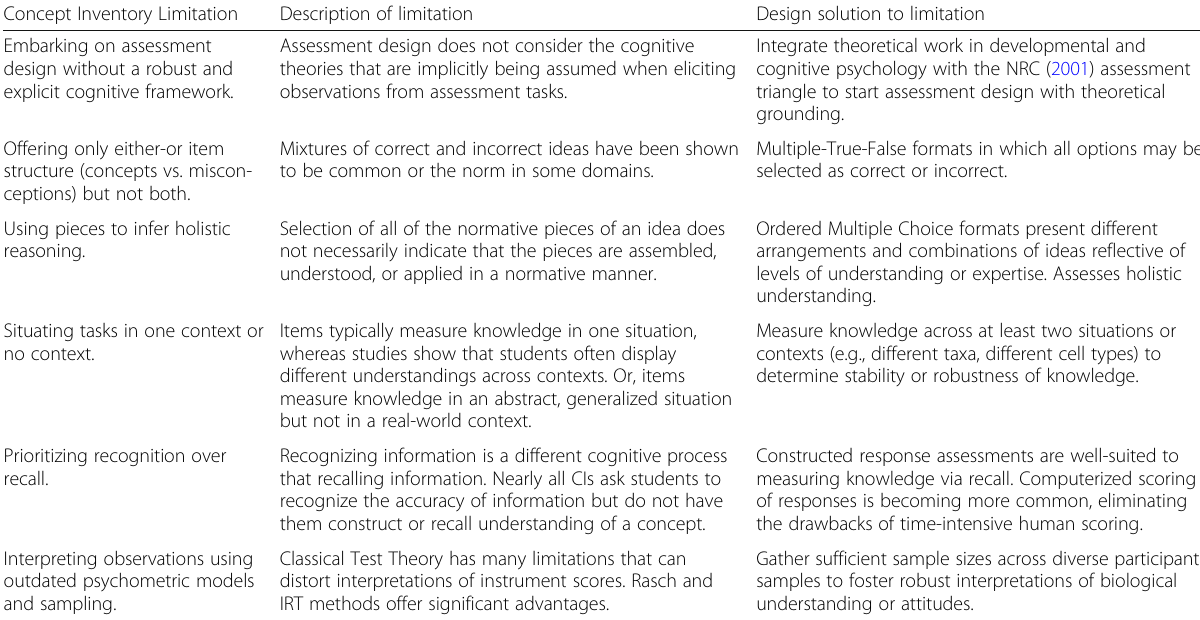
Table 3 Uncovering Student Thinking about Living Systems. Concept Inventories (CIs) and their associated design solutions for the valid assessment of biological understanding in light of the assessment